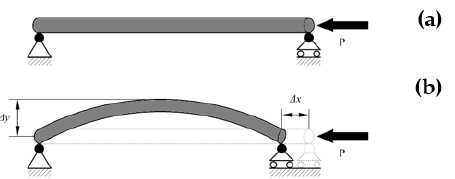
Figure 1. Schematic illustration of axial compression of simply supported SGC. ( a ) Before buckling deformation; ( b ) after buckling deformation.